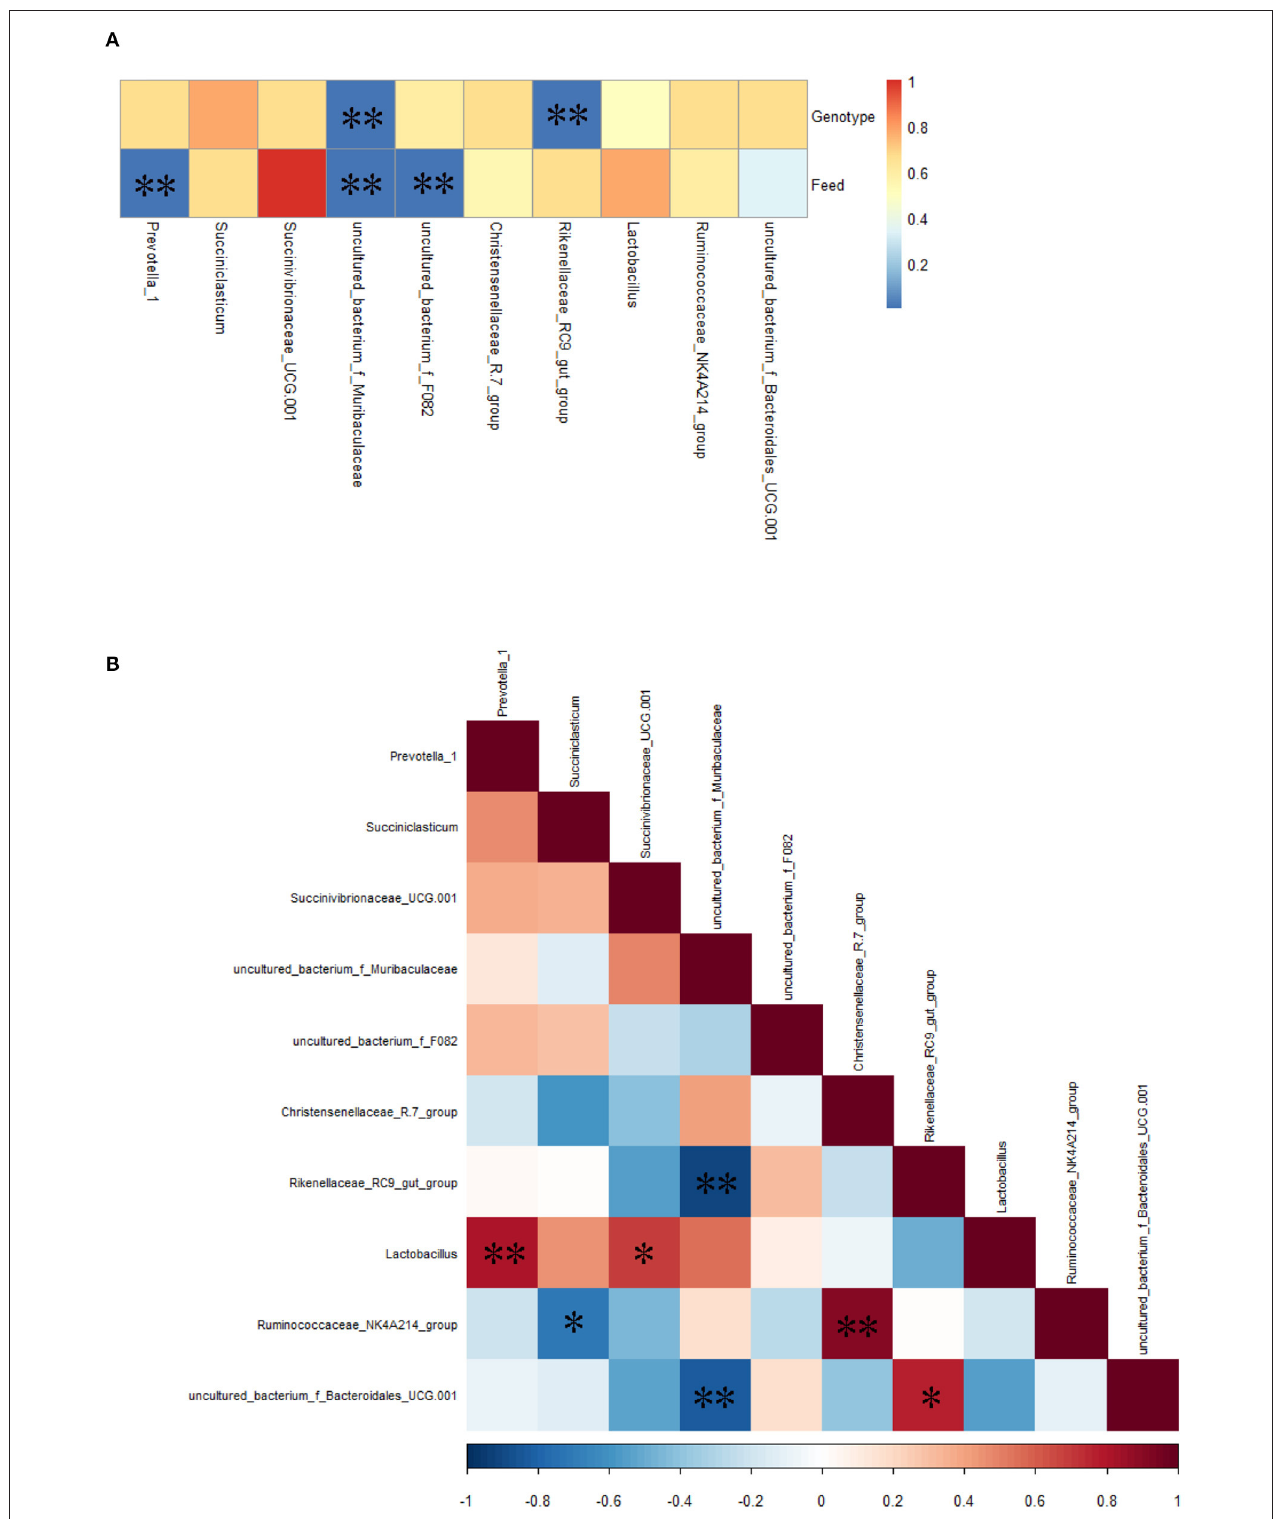
FIGURE 5 | (A) Spearman correlations between the top 10 most abundant genera of rumen bacteria and bovine genotype and feed, (B) mutual-correlation among the top 10 genera. Color indicates (A) P -values and (B) correlation index ( r ); (B) Red represents a positive correlation, and blue represents a negative correlation. * P < 0.05, ** P <